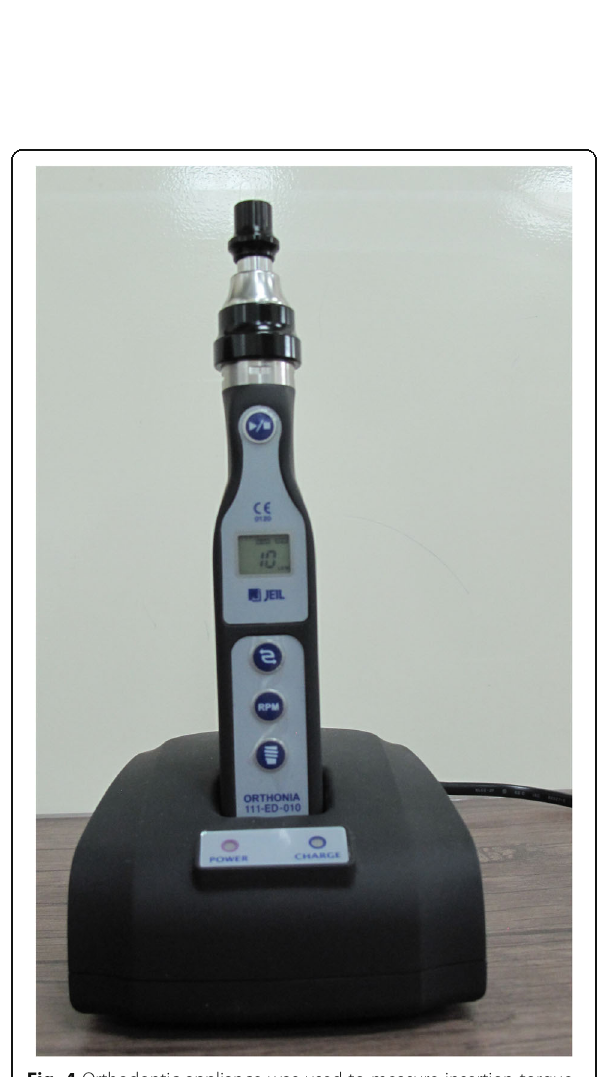
Fig. 4 Orthodontic appliance was used to measure insertion